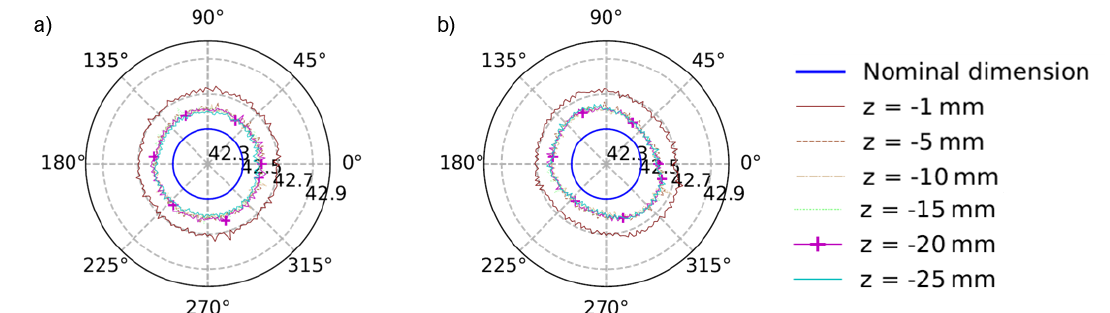
Figure 7. Dependence of the outer radius on height and angle, measured from specimen D85 sectional strategy: ( a ) before and ( b ) after